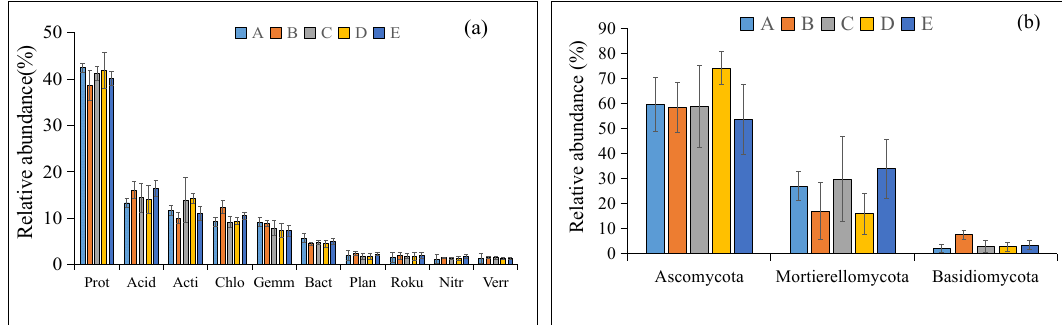
Figure 1. Relative abundance of the dominant groups of bacterial ( a ) and fungal ( b ) communities at the phylum level among the different treatments. A indicates 0% (NC), B indicates 20% (LIC), C indicates 40% (MIC 1 ), D indicates 60% (MIC 2 ) and E indicates 80% (HIC). Prot indicates Proteobacteria, Acid indicates Acidobacteria, Acti indicates Actinobacteria, Chlo indicates Chloroflexi, Gemm indicates Gemmatimonadetes, Bact indicates Bacteroidetes, Plan indicates Planctomycetes, Roku indicates Rokubacteria, Nitr indicates Nitrospirae and Verr indicates Verrucomicrobia.